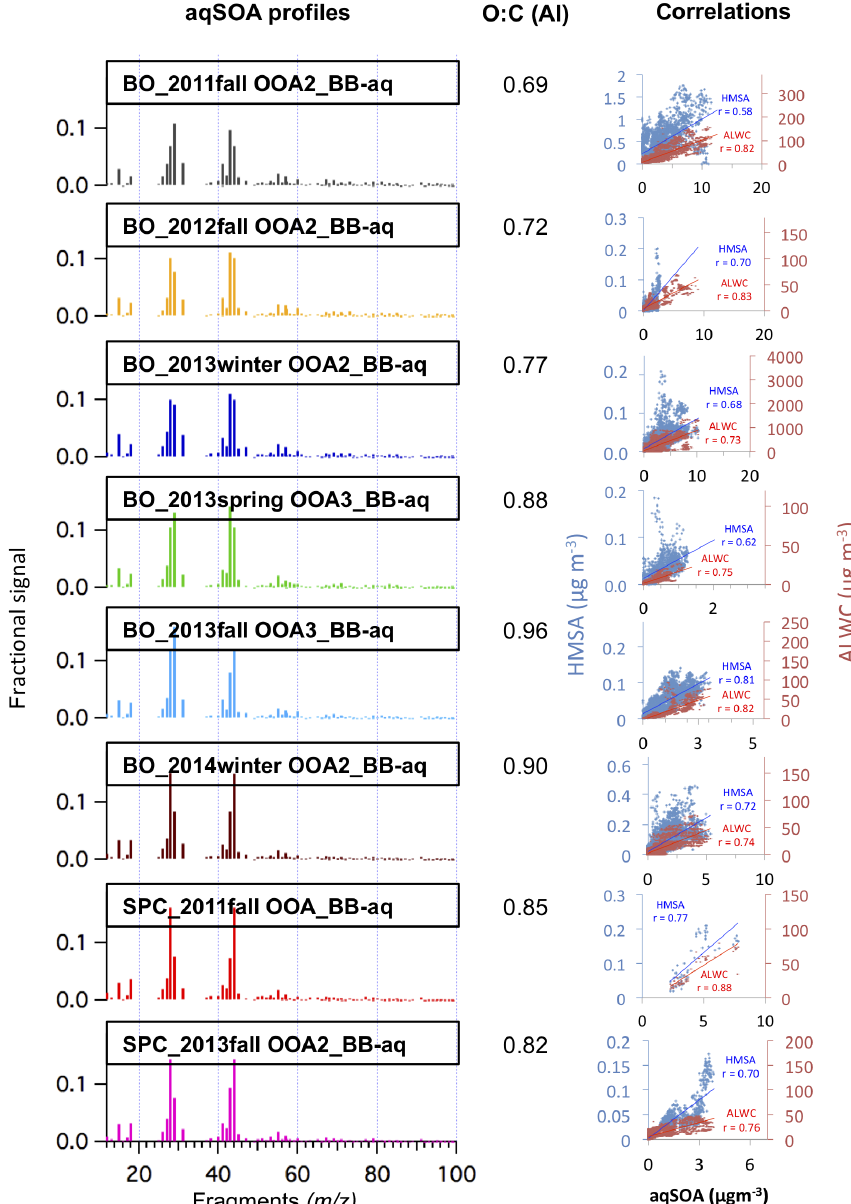
Figure 9. OOAx_BB-aq main features: the left column shows the mass spectral profile of each BB-aqSOA component identified during the Supersito campaigns; the OOA factors are numerically ordered for each campaign based on their O:C ratios; the central column shows the O:C elemental ratios of the same factors; the right column illustrates the correlation between their concentration time series and the HMSA (in blue) and the ALWC (in